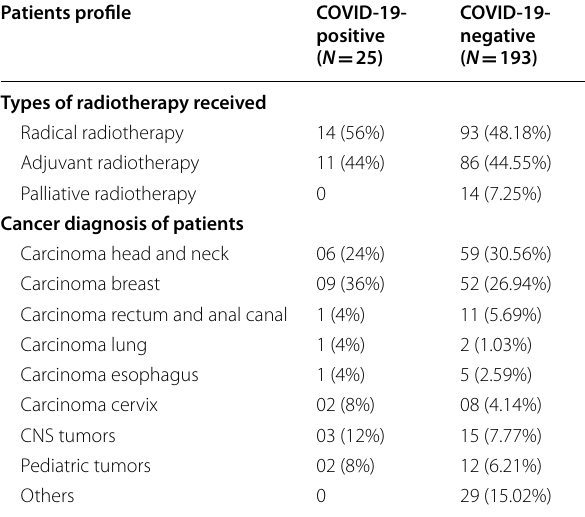
Table 2 Intent of treatment and patient diagnosis Patients profile